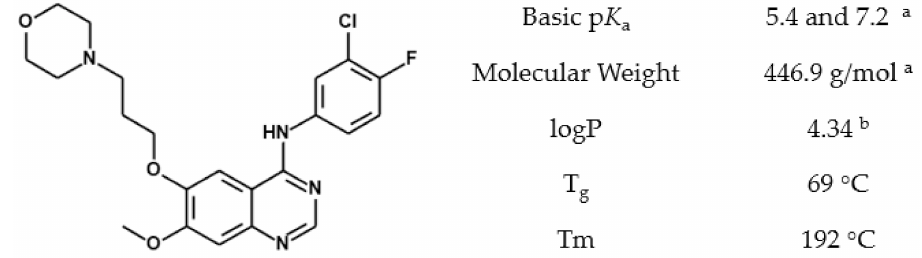
Figure 1. Gefitinib chemical structure and physicochemical properties. a Reference [26]. b Calculated using ADMET Predictor™ (Simulations Plus, Lancaster, CA, USA) version